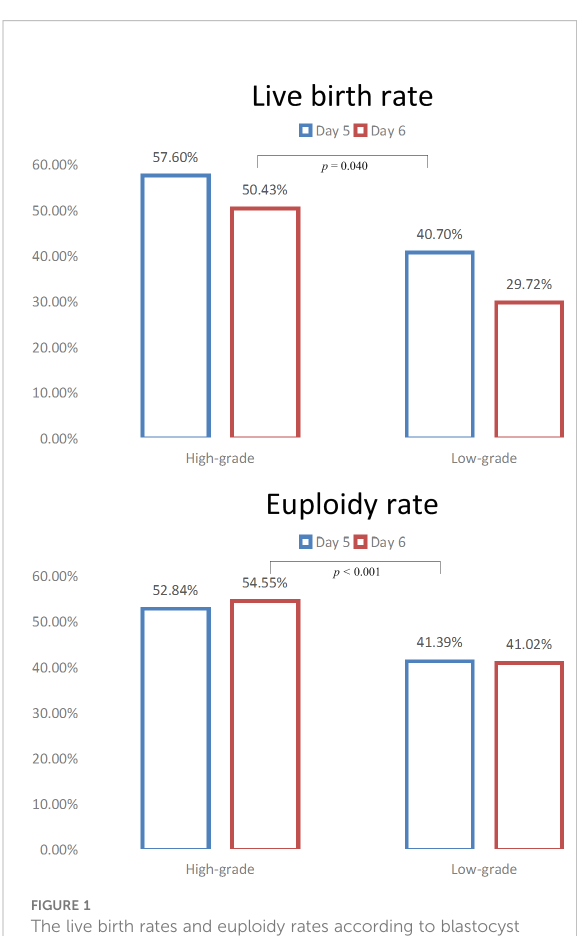
FIGURE 1 The live birth rates and euploidy rates according to blastocyst grading and expansion